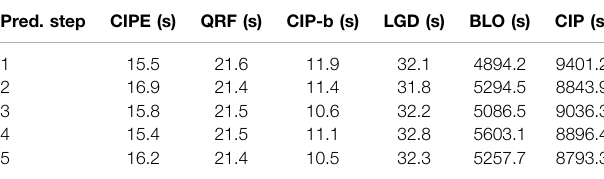
TABLE6| Trainingtimeofdifferentmodelsunder PINC =90%inmulti-stepahead